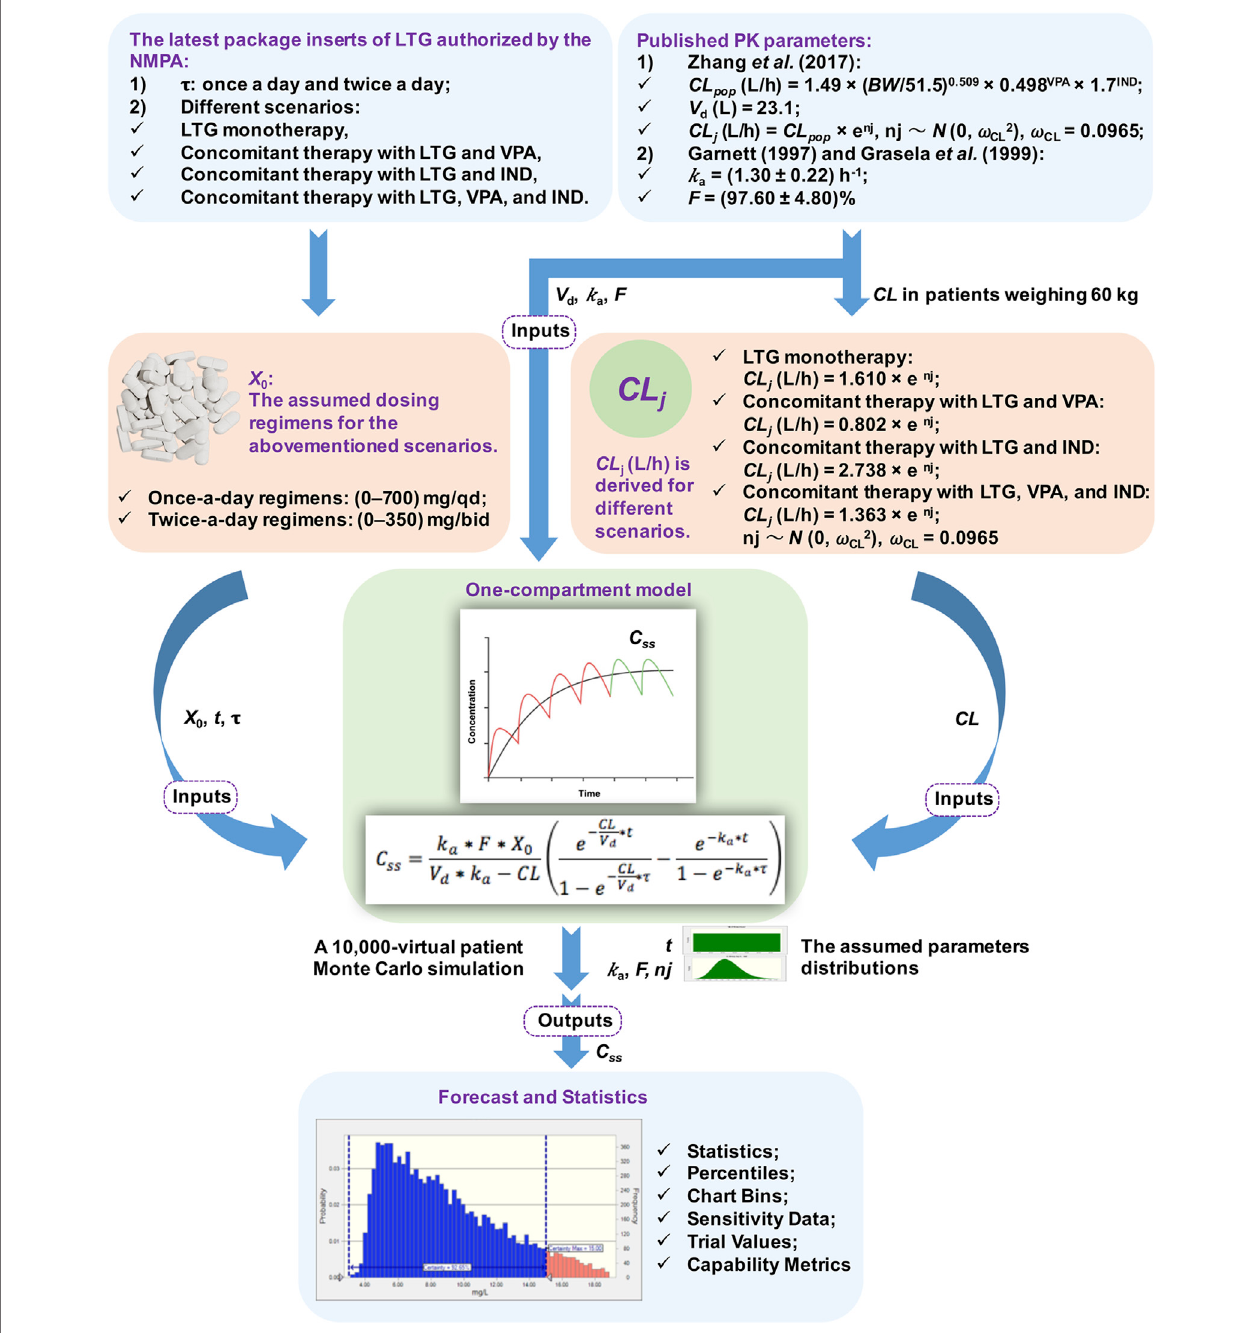
FIGURE 1 | Flowchart of the Monte Carlo (MC) simulation. Note. NMPA: The National Medical Products Administration, τ : the dosing interval, LTG: lamotrigine, VPA:valproateacid,IND:enzymeinducer,PK:pharmacokinetic, CL :totalserumclearance, BW :totalbodyweight, V d :theapparentvolumeofdistribution, k a :therateof absorption, F : the absolute bioavailability of the form of oral dosage, X 0 : a single dose, t : the time of blood sampling, C ss : steady-state serum concentrations, ω CL : the inter-individual random error on CL , nj: the inter-individual variability in CL , CL pop : the population mean CL , CL j : the CL of the j th virtual patient.